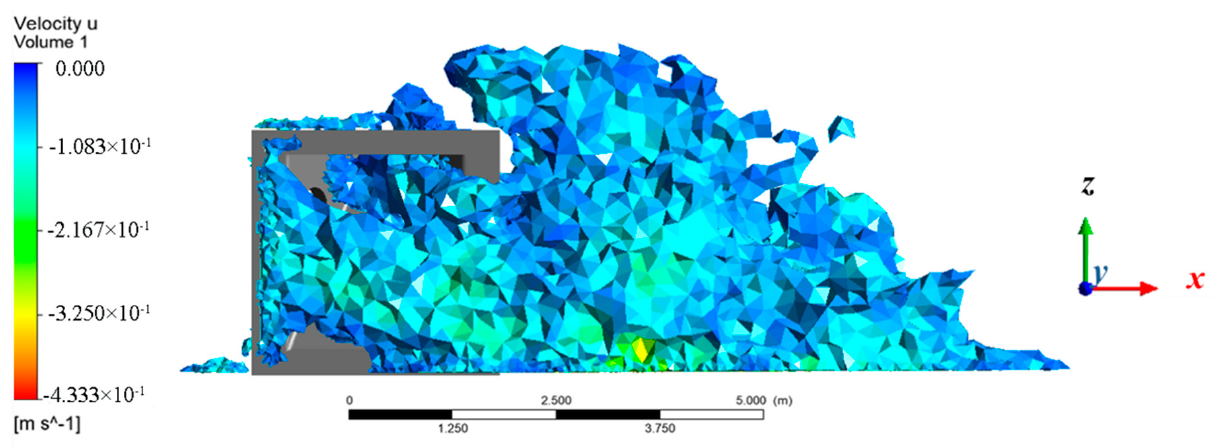
Figure 7. Wake volume. Figure 7. Wake